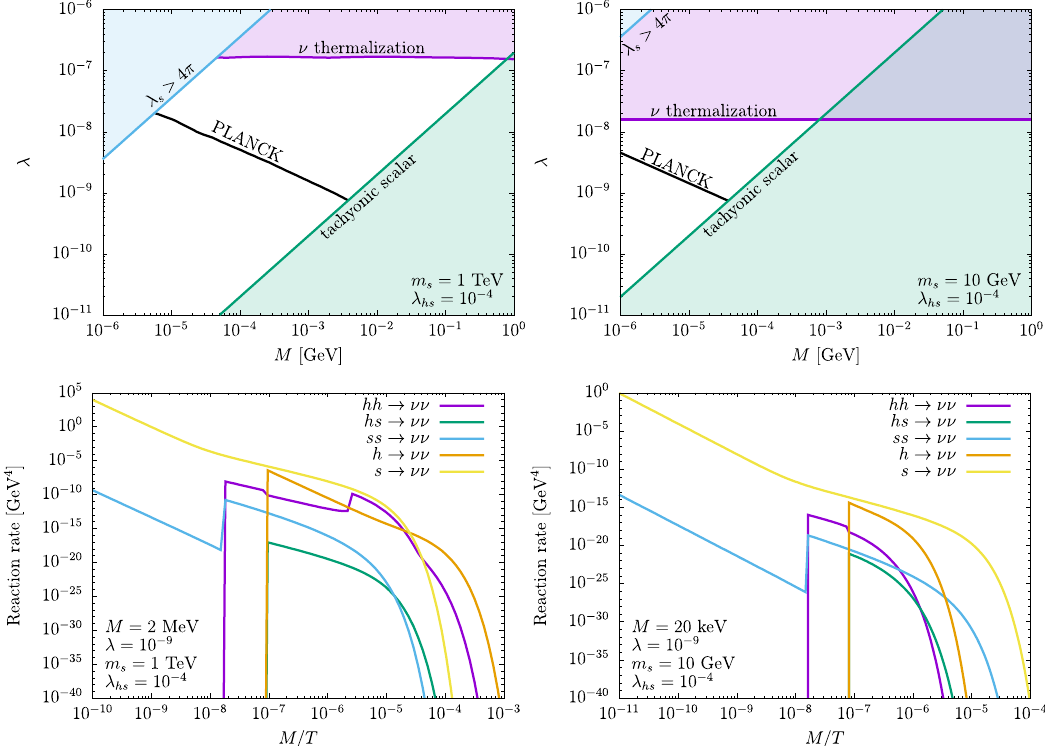
Figure 6 . Upper panels: (cid:21) vs M producing the correct DM relic density (\PLANCK"). The dominant DM production mode is s ! (cid:23)(cid:23) . Lower panels: Reaction rates. The kinks appear due to phase transitions which bring in new modes as well as due to T -dependent